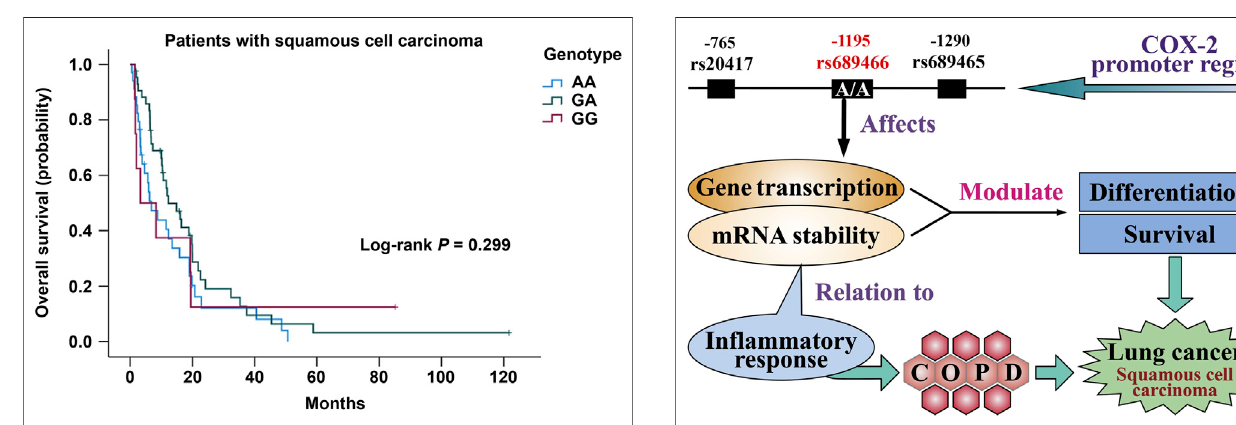
FIGURE 2 | Potential function of the COX-2 single nucleotide polymorphisms in lung cancer. The genotype of homozygous COX-2 – 1195A in the COX-2 promoter region affects gene transcription, thereby increasing the expression of COX-2 in lung cells. The in fl ammatory response is related to mRNA stability. Both factors enhance the level of differentiation of lung cells and promote the development of lung squamous cell carcinoma. The in fl ammatory response also leads to chronic obstructive pulmonary disease and lung